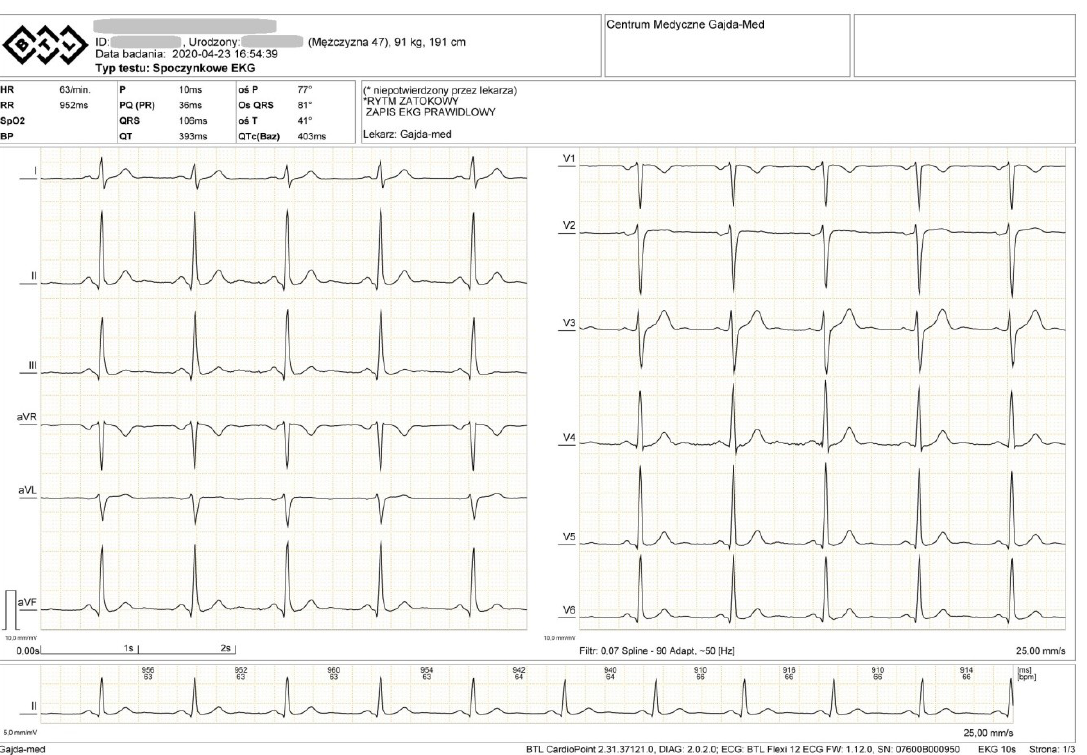
Table 2. Main characteristics of tachycardia events in the analyzed athlete. Figure 2. Intensity and time of atrioventricular nodal re-entrant tachycardia (AVNRT) in 2014–2020 of analyzed patient.